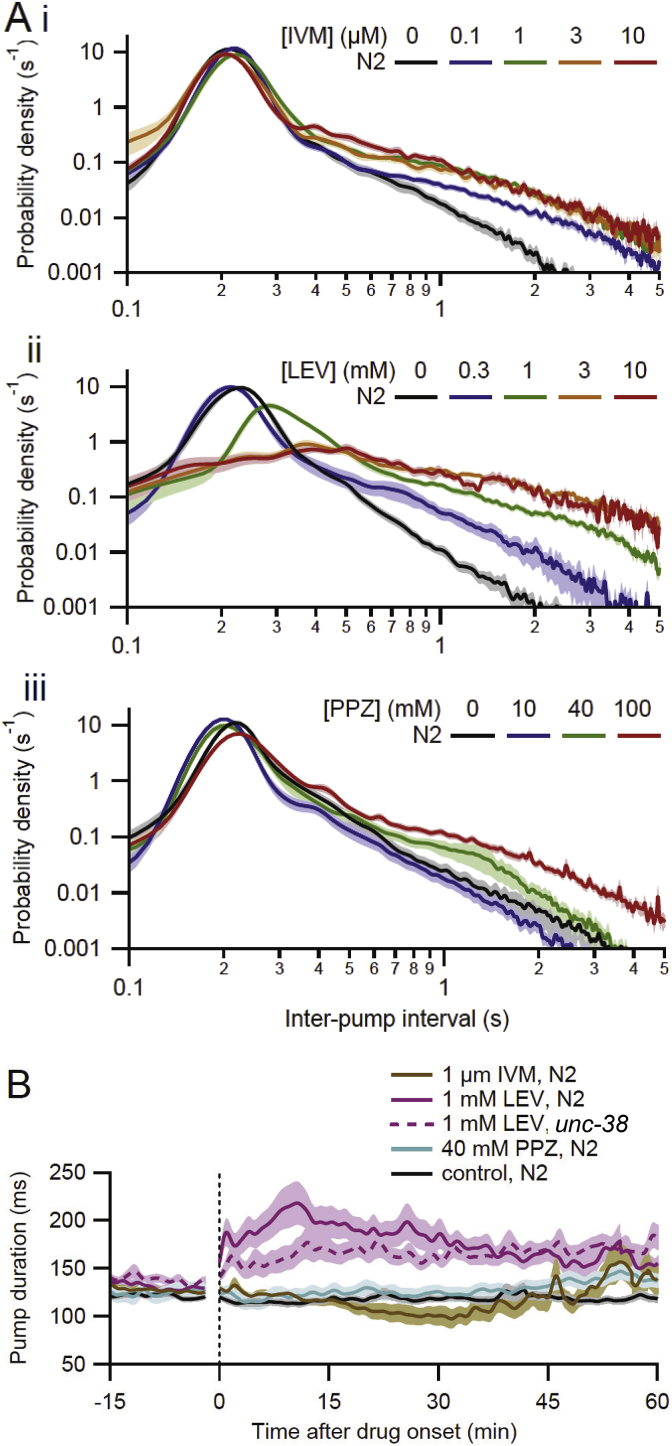
Inter-pump interval (IPI) and pump duration data for three anthelmintic drugs. A. IPI probability density histograms from N2 worms during t = 0–60 min for i. IVM, ii. LEV and iii. PPZ (same data as Fig. 4, Fig. 7, Fig. 9, respectively). Drug concentrations are given in keys. Control data are from Fig. 4. B. Plot of pump duration (interval from E to R spike) during t = −15 to 60 min for same three drugs; see key. Perfusate switch occurred at the vertical dotted line, with the electrical artifact blanked. Data are shown for a representative, intermediate concentration of each drug at which pumping continued for the entire 60-min post-switch period. All data are from N2 worms (solid lines) except for unc-38 (LEV-resistant; dashed line), included for comparison. (For interpretation of the references to color in this figure legend, the reader is referred to the Web version of this article.)